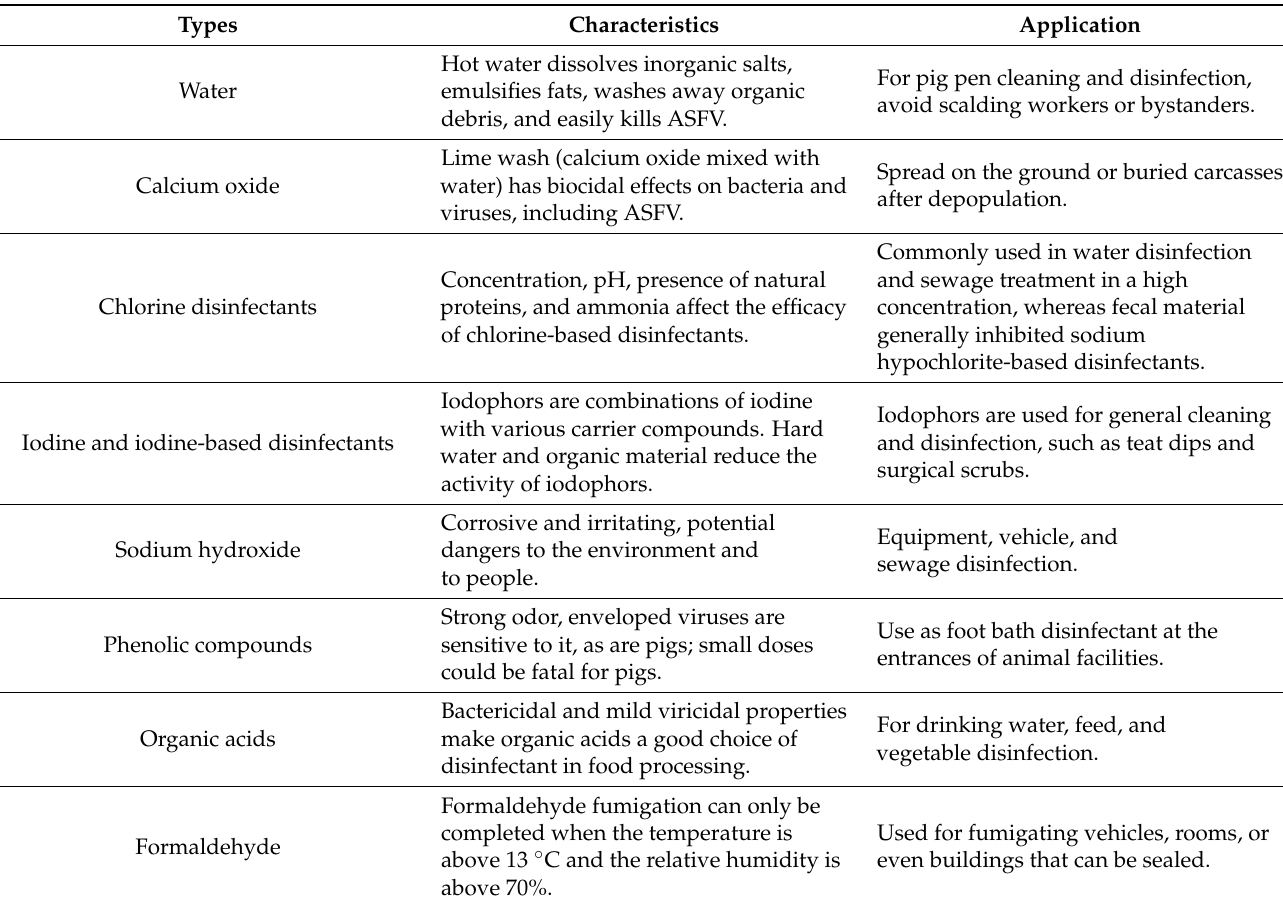
Table 3. Different disinfection methods and their common